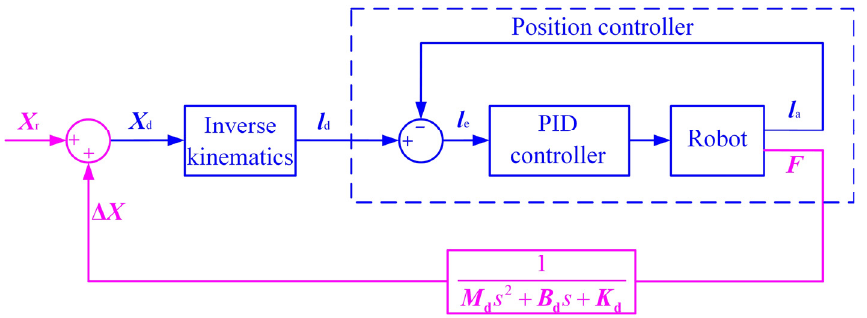
Figure 2. Position-based impedance control strategy diagram.